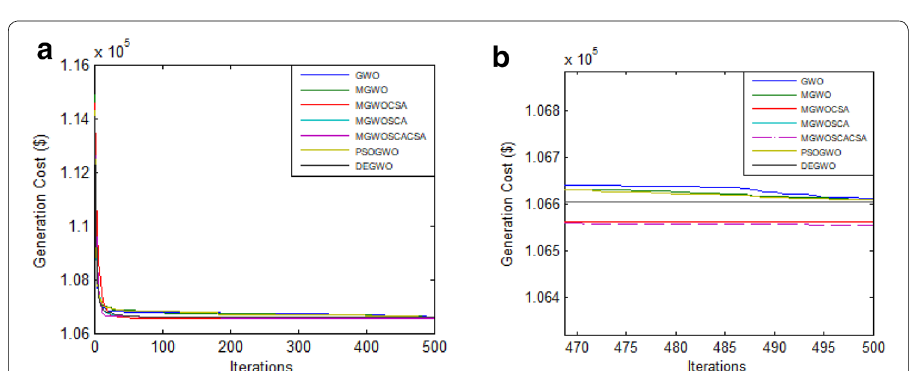
Fig. 10 a Convergence curve characteristics for EED in Case 3 with forecasted wind and load profile. b Magnified to differentiate the proposed